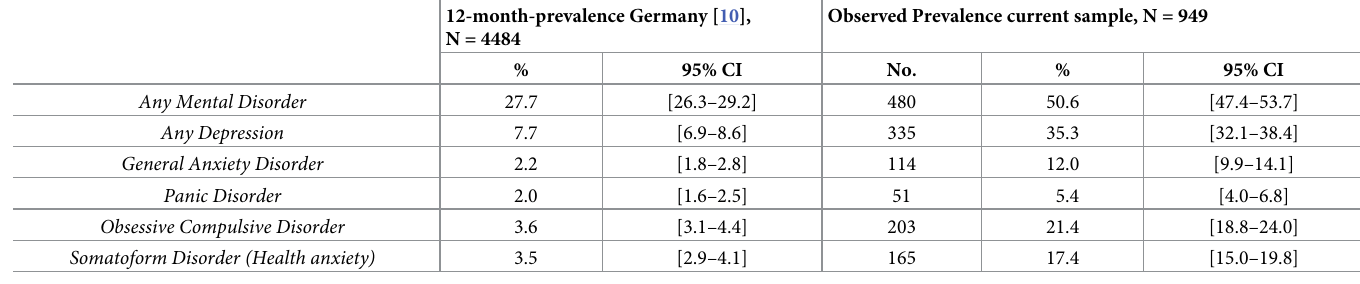
Table 2. 12-month-prevalence of various mental disorders in Germany before the Covid-19 pandemic, and prevalence assessed during the lockdown in total num- bers (No.) and frequencies (%).